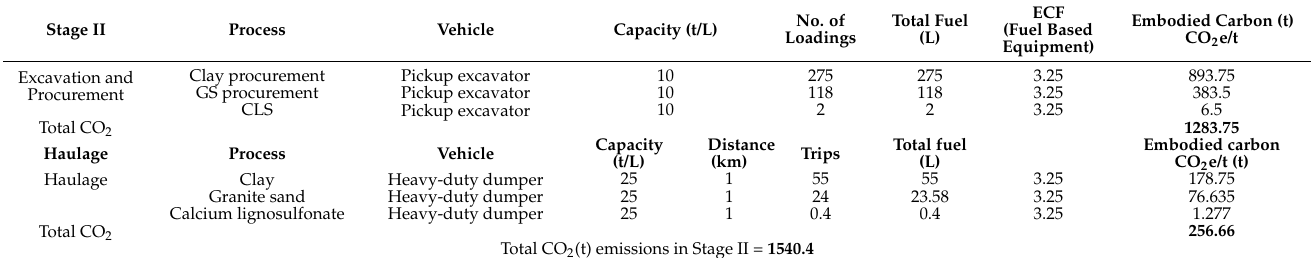
Table 5. Evaluation of carbon emissions from procurement and haulage.